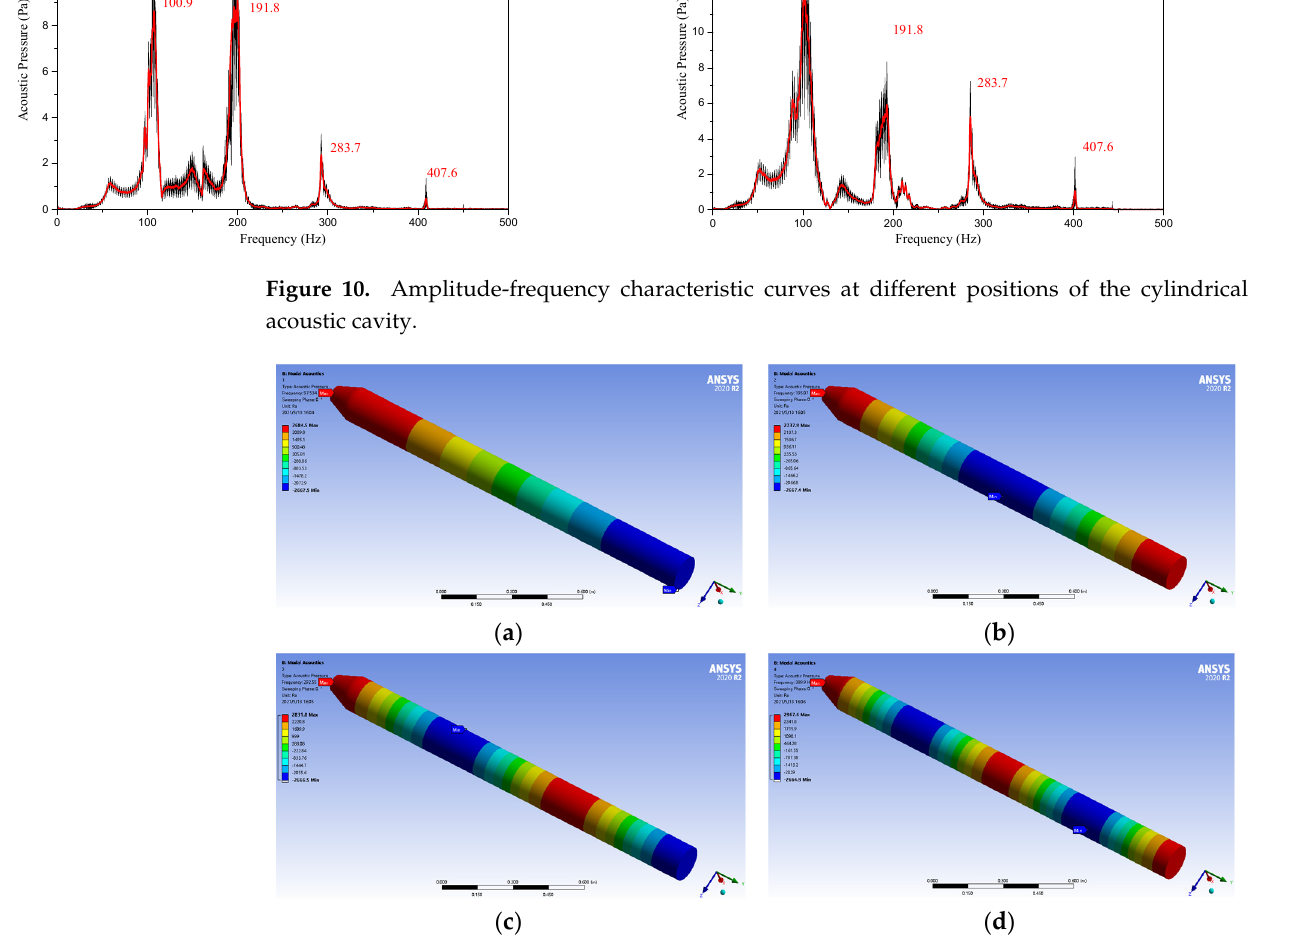
Figure 11. The first four-order vibration modes of the acoustic cavity models, ( a ) 1st Order vibration modes, ( b ) 2nd Order vibration modes, ( c ) 3rd Order vibration modes and ( d ) 4th Order vibration modes.